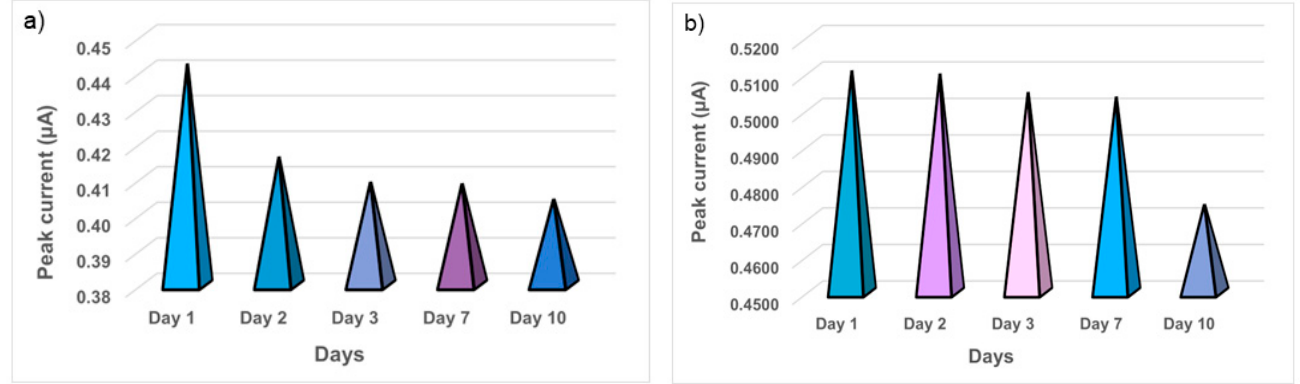
Figure 10. Stability of the ( a ) PIX/AuNPsnGr and ( b ) PIXCoCl/AuNPsnGr sensors for a period of 10 days.